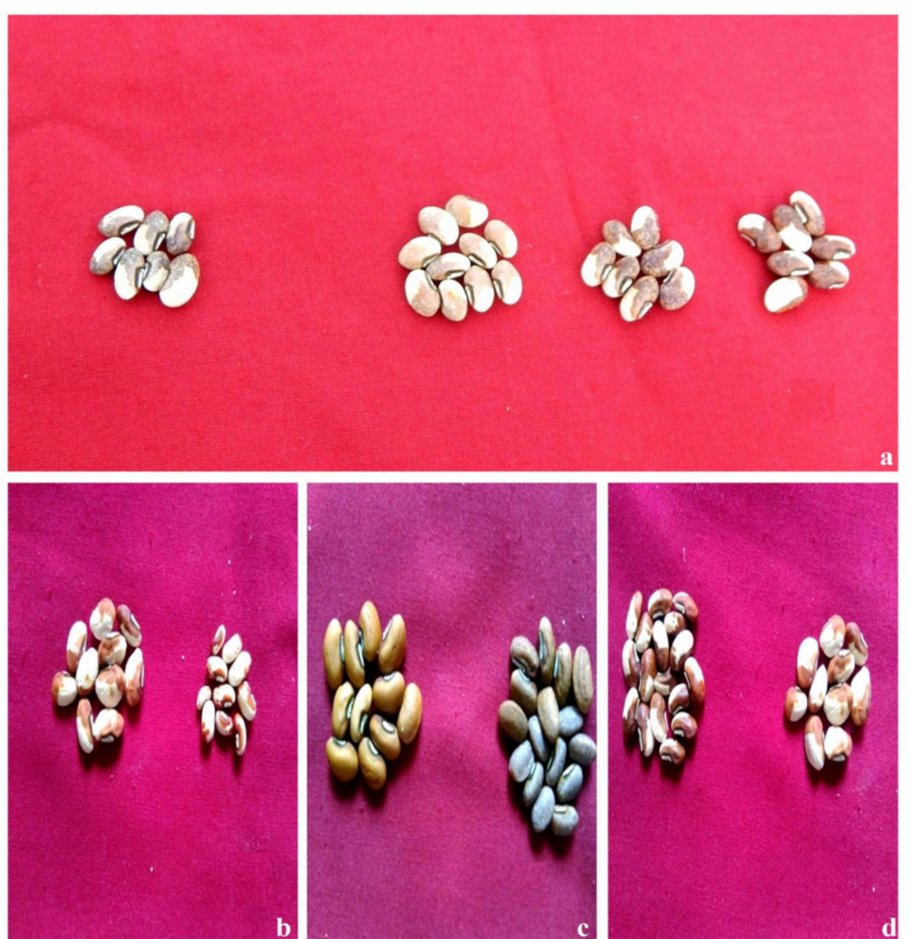
Figure 10. Representative photographs of gamma rays and sodium azide -induced alterations in seed pattern, color, and shape. ( a ) Seed coat color variations, ( b ) bold and small seeds, ( c ) smooth seeds, ( d ) wrinkled